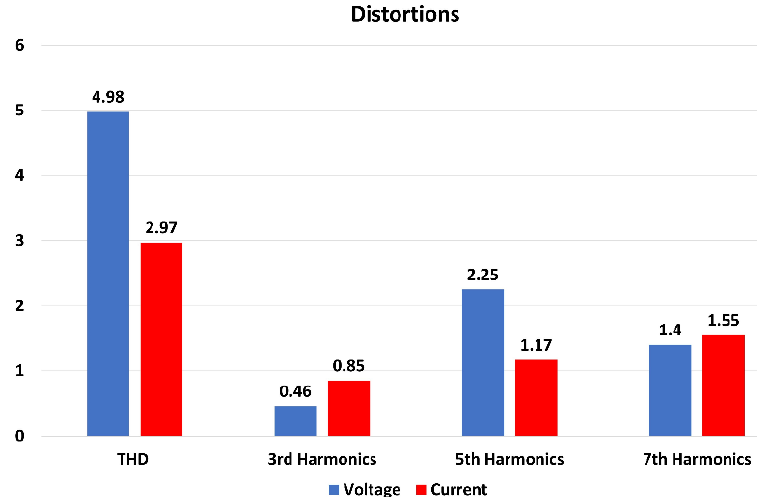
Figure 9. 3rd, 5th, and 7th harmonics and THD values of phase voltages and currents.